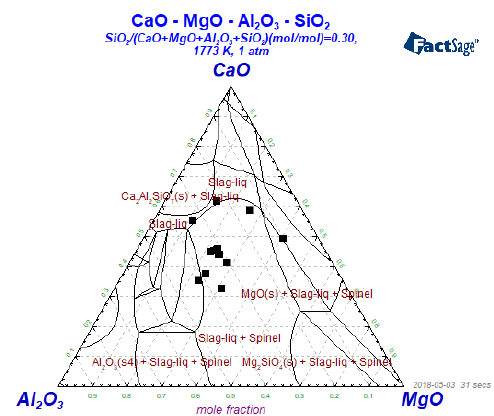
Figure 7. Chemical composition of the inclusions during the AOD-LF-CC process.